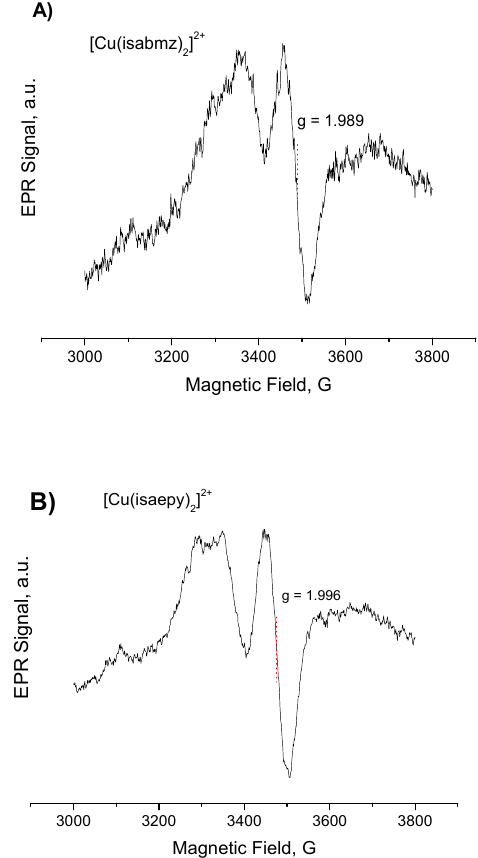
Figure 3. EPR spectra of radical species formed by oxidation of HSA (0.600 mM), in the presence of [H 2 O 2 ] = 2.5 mM and each of the complexes (100 µ M), [Cu(isambz) 2 ] 2+ 1 ( A ) or [Cu(isaepy) 2 ] 2+ ( B ).